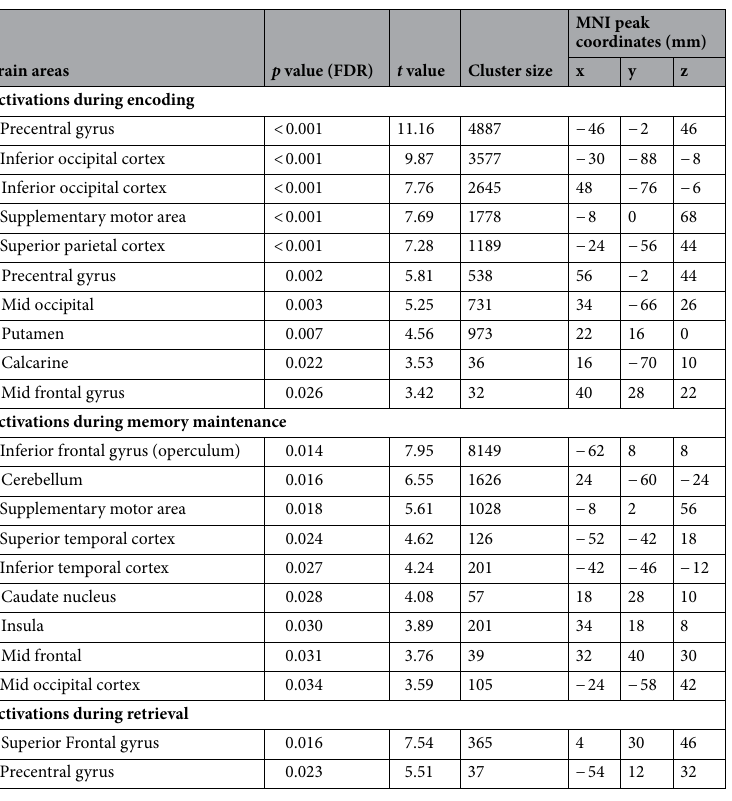
Table 3. Significant areas of activation during the encoding, memory and retrieval time intervals in the memory load contrast (threshold at FDR 0.05). Peak coordinates in MNI space are listed using the Talairach coordinate system. t values are reported for magnitude of activation. Only cluster sizes > 30 are presented. Anatomical labels for peak coordinates were derived from the MRIcroN software and SPM 8. L, Left; R,